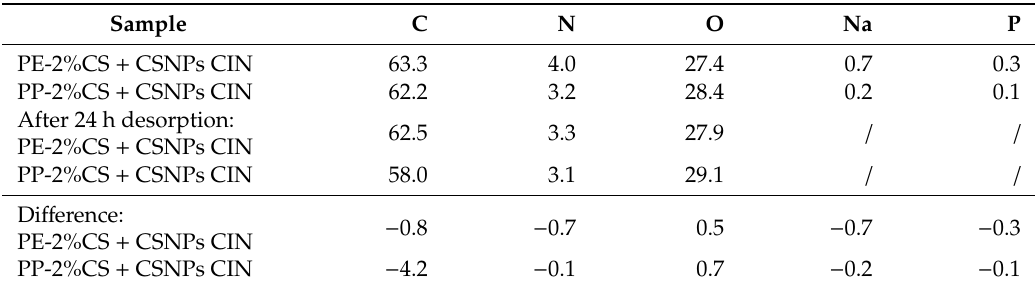
Table 8. Surface chemical composition of PE / PP-2%CS + CSNPs CIN-coated foils before and after desorption experiment